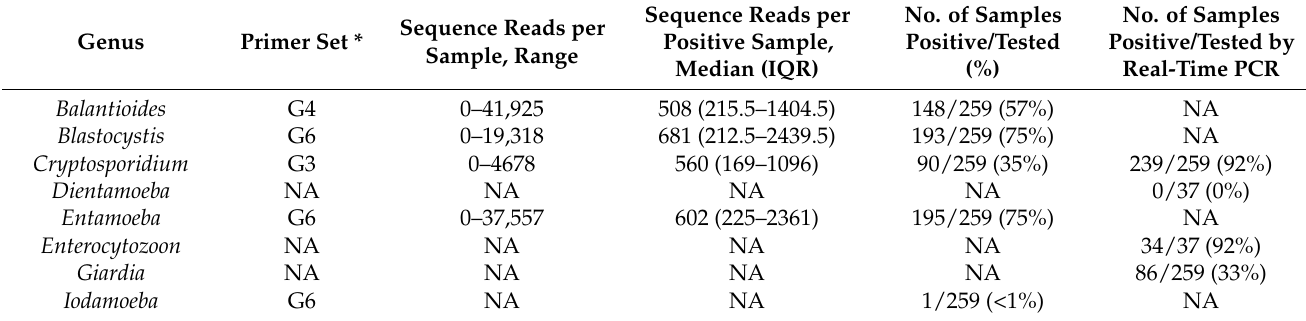
Table 3. DNA sequence read yield obtained per genus by metabarcoding of 259 fecal DNAs from pigs from four different herds in